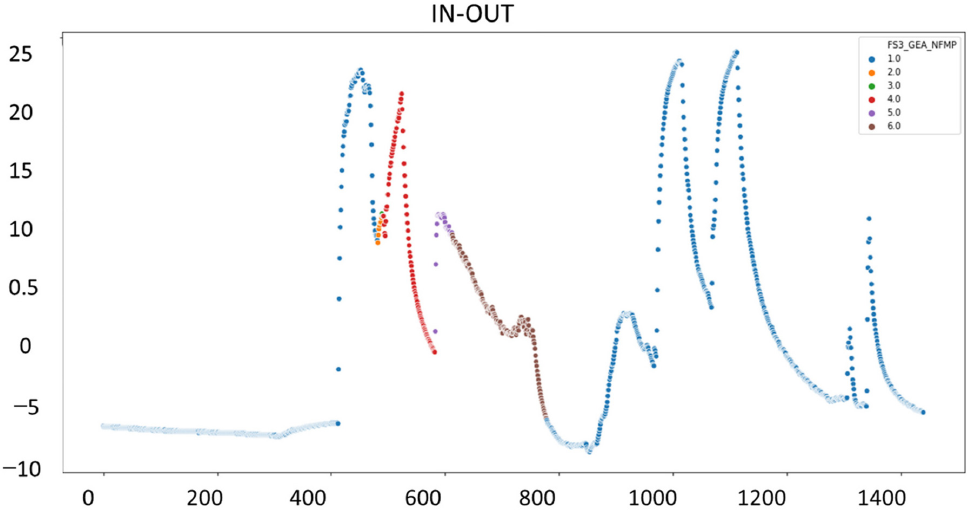
Figure 5 indicates on the x-axis the elapsed time (1400 min in total) and on the y-axis the difference in temperature of the fluid bed dryer’s inlet and outlet air.